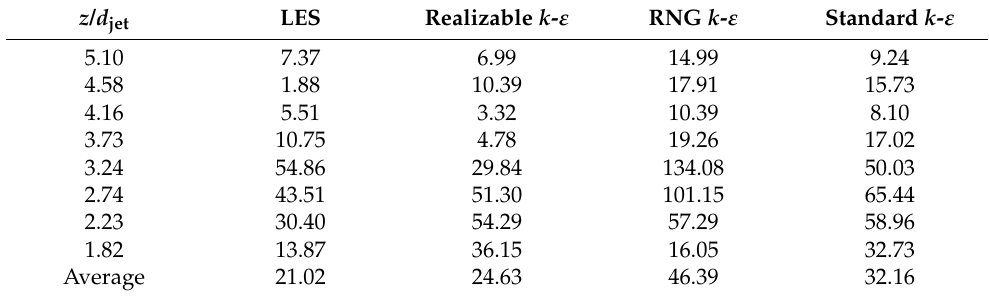
Table 9. Relative errors (%) between the simulated and experimental results on the line x / d jet = 3.67. z / d jet LES Realizable k - ε RNG k -